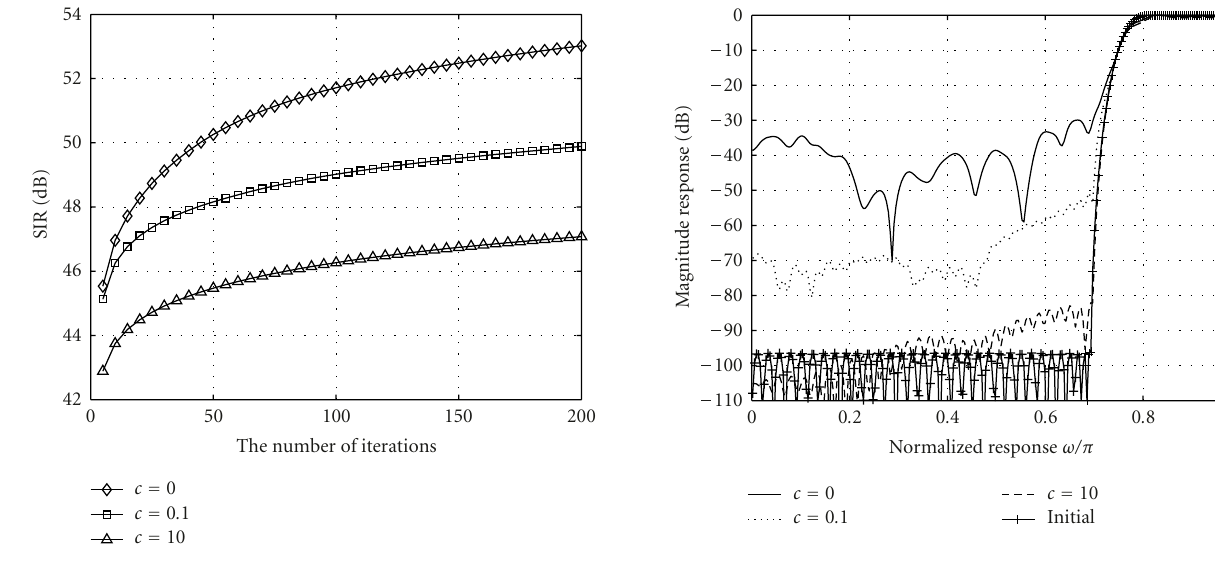
Figure 12: Magnitude response of F 1 ( z ).